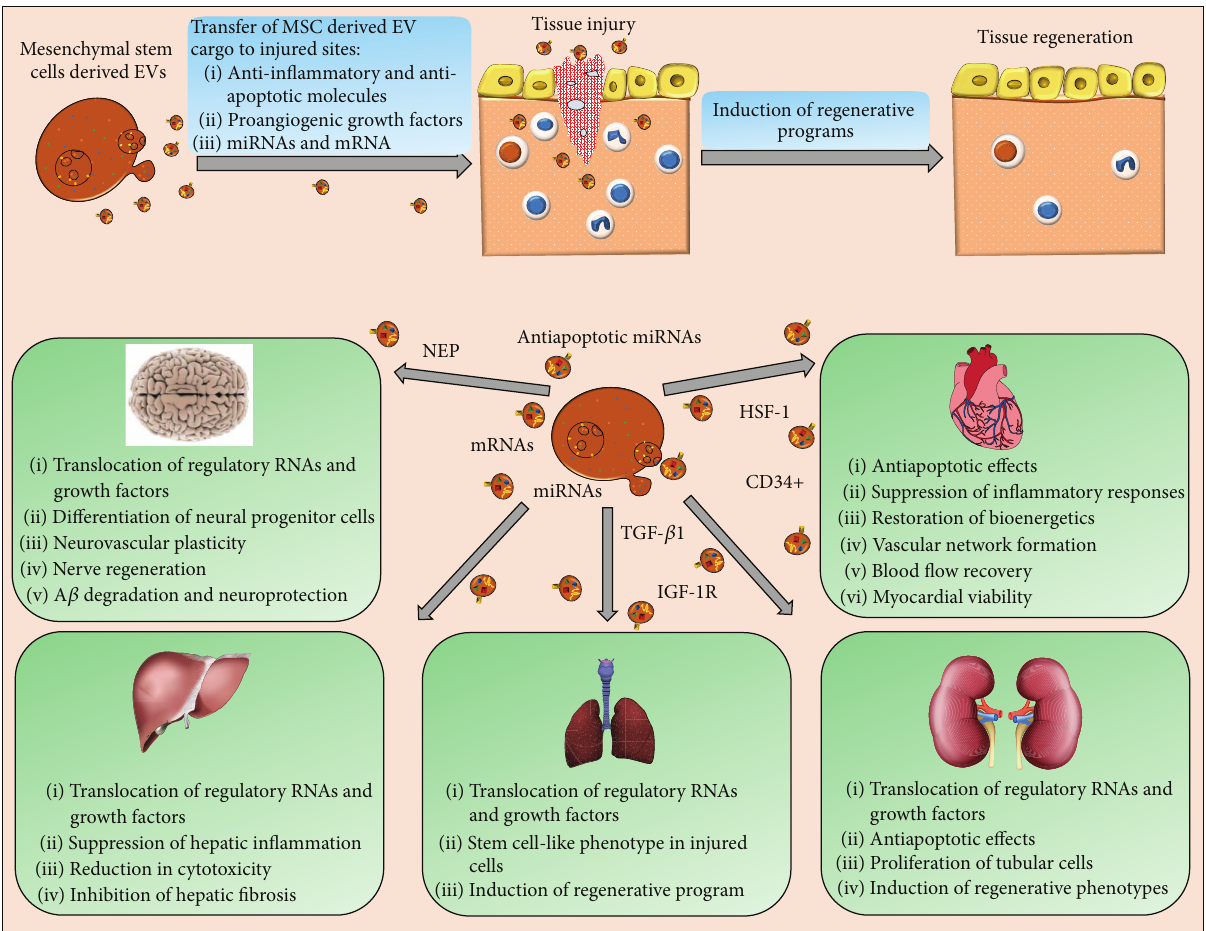
Figure 3: Schematic representation of the regenerative effects of stem cell-derived EVs. MSCs use EVs to ameliorate tissue damage through translocating growth factors, anti-inflammatory, antiapoptotic, and proangiogenic molecules, to sites of injury where they induce and regulate regenerative